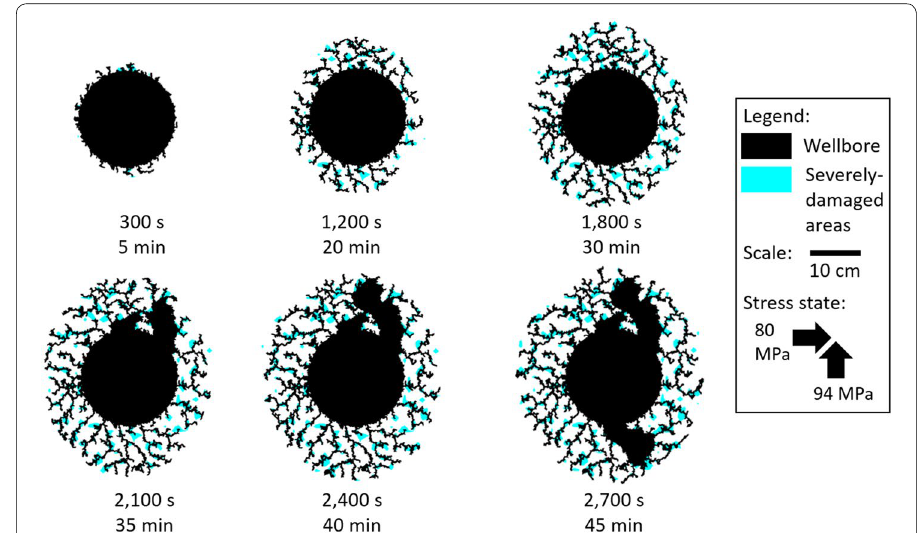
Fig. 17 Example of a separation of pieces of rock in the near‑wellbore area, for the stress state case D, with high heat transfer coefficient value— h 10,000 W m − 2 K − 1 , pressure in the wellbore 50 MPa. In this figure, = = black color corresponds to the wellbore and to separated pieces of rock matrix, cyan color corresponds to unseparated but severely damaged areas (defined as area with more than 6 cracks cm − 2